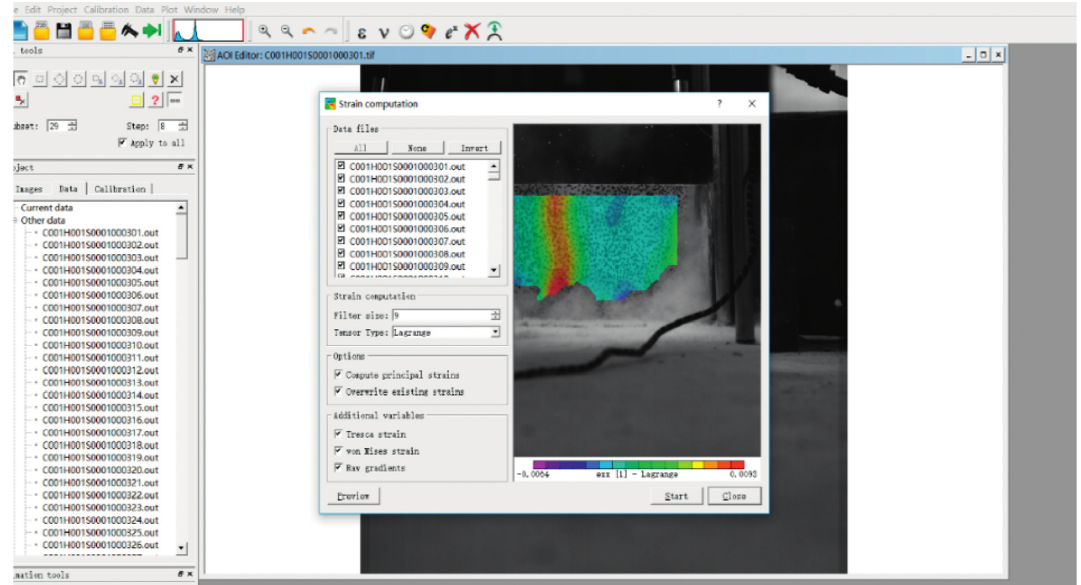
Figure 3: DIC analysis